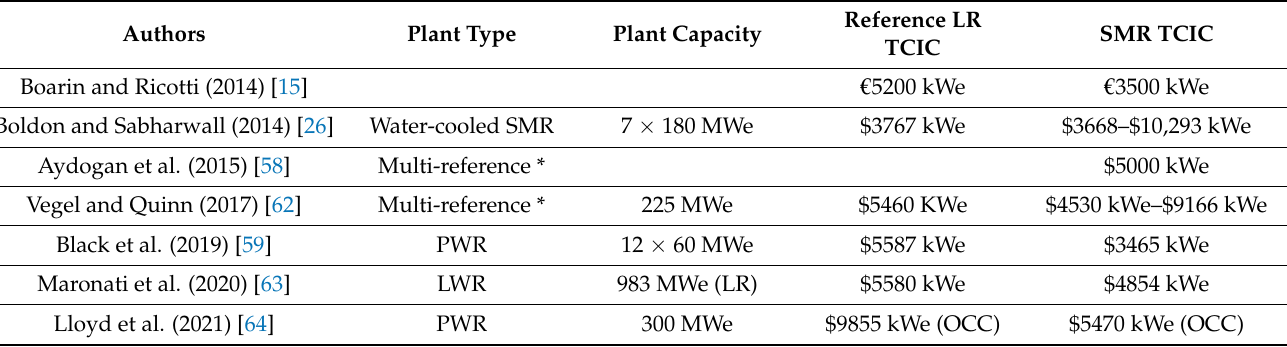
Table 3. TCIC cost estimation of various authors.